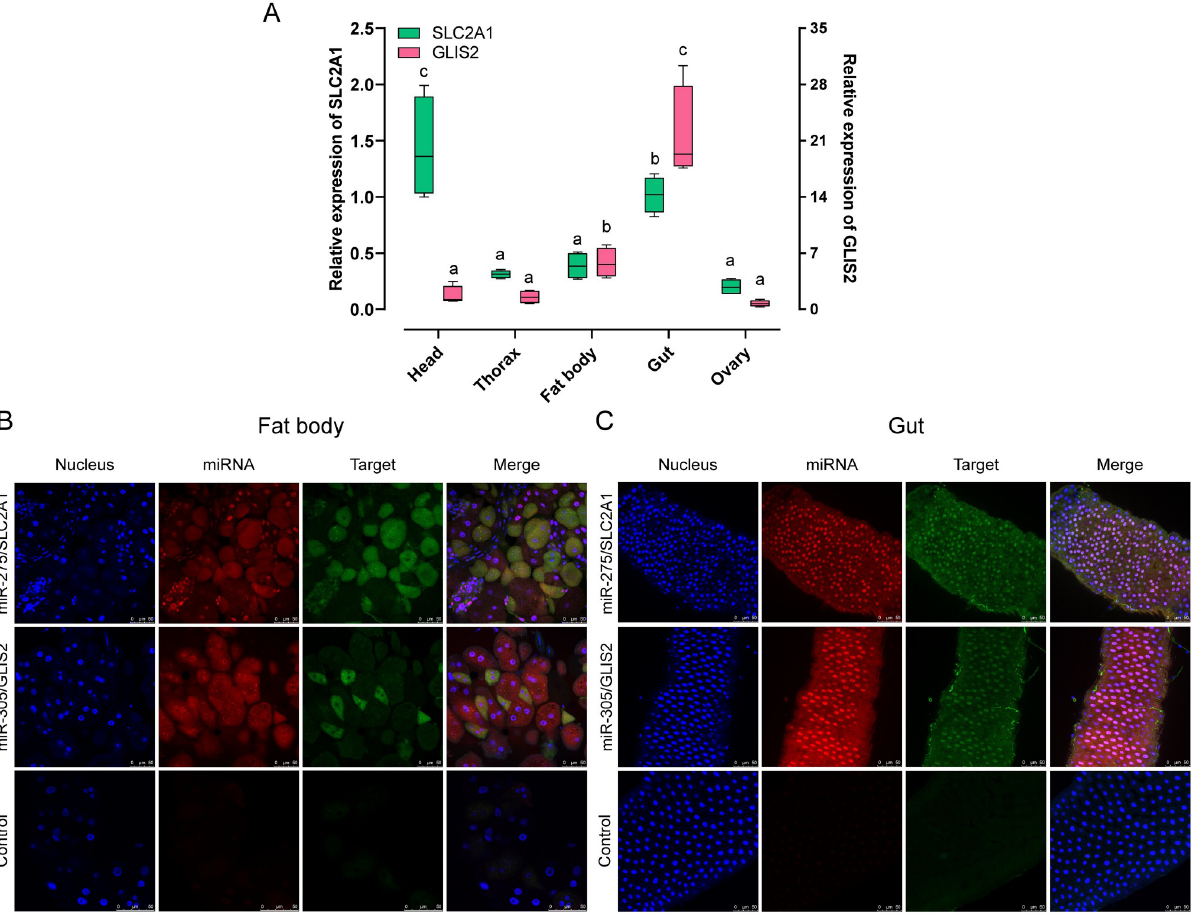
Fig 6. Tissue-specific expression profile of target genes and RNA in situ hybridization. (A-B) Tissue-specific expression patterns of SLC2A1 (A) and GLIS2 (B) with 5-day-old females. Data are expressed as mean ± SEM from five biological replicates. The lowercase letters above bars indicate significant differences by one-way ANOVA followed by Tukey’s multiple comparisons test. (C-D) RNA-FISH detection of miR-275/miR-305 (Red) and SLC2A1/GLIS2 (Green) in the fat body (C) and gut (D) of wild-type flies. The images were visualized using Leica TCS SP8 confocal laser scanning microscope (Zeiss, Germany) at a magnification of 40 x. Scale bar: 50 μ